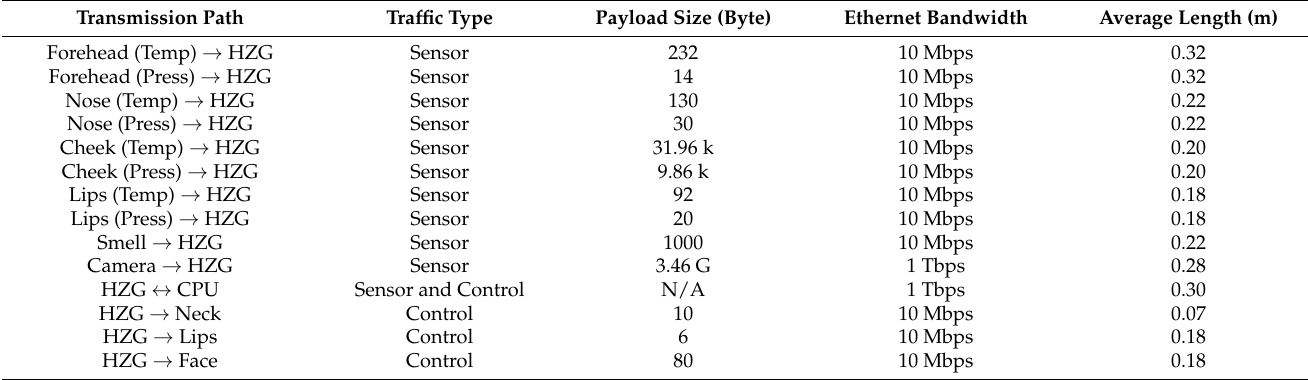
Table 5. Data transmission link parameters of the ZIRA Head